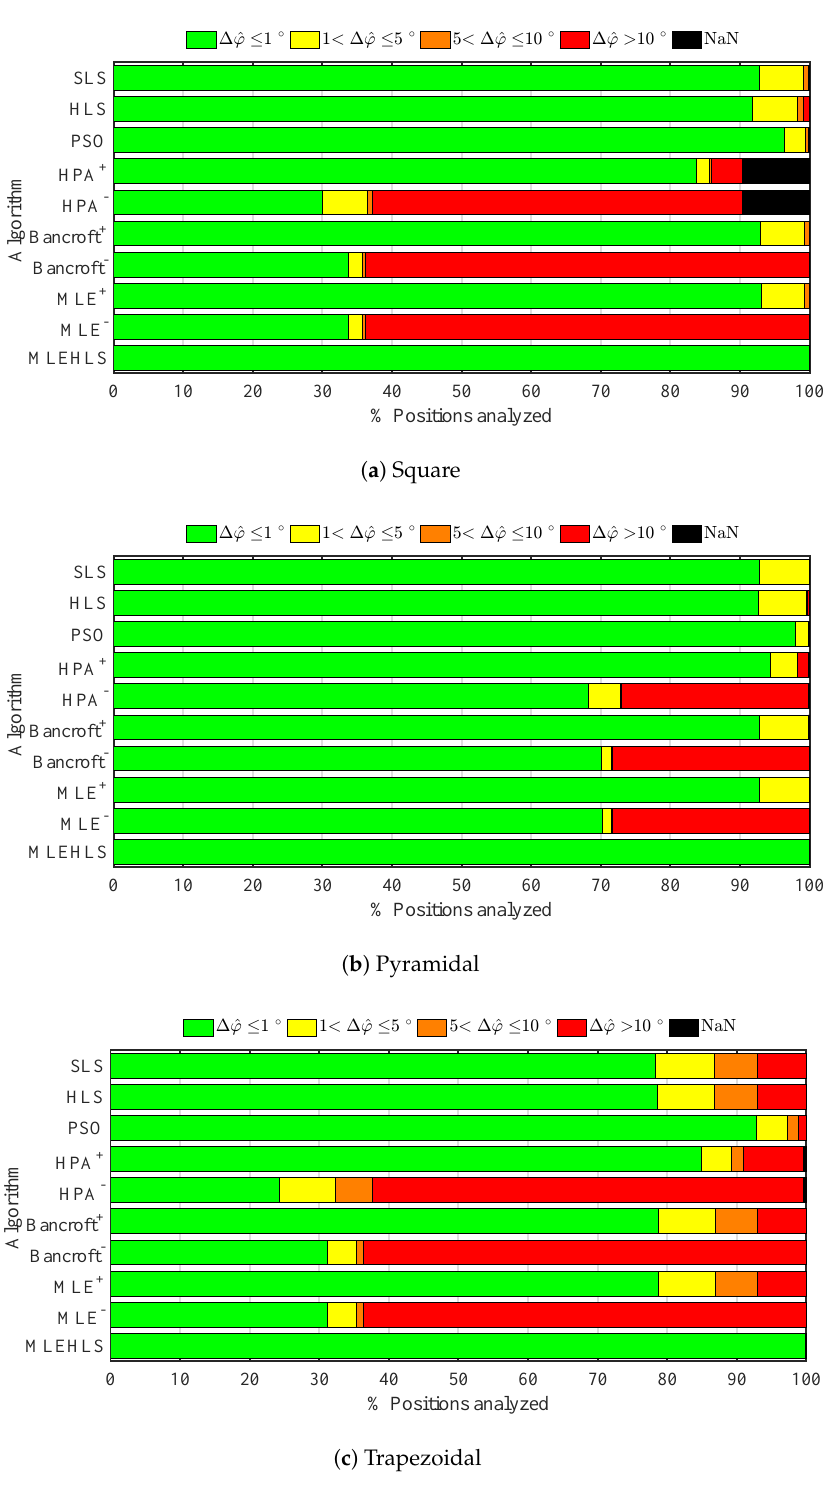
Figure 6. Percentage of positions located within the errors in the azimuth angle ∆ ˆ ϕ in degrees defined in the legend under theoretical conditions for each algorithm and antenna array